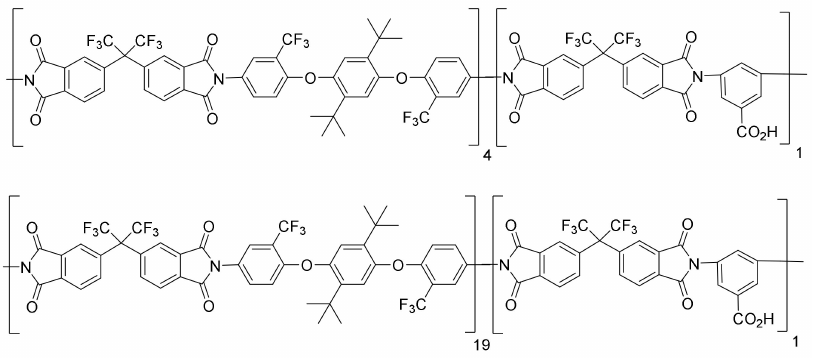
Figure 3. Chemical structure of copolymers 6FDA-[DABA-CF 3 TBAPB (1/4)] and 6FDA-[DABA- CF 3 TBAPB